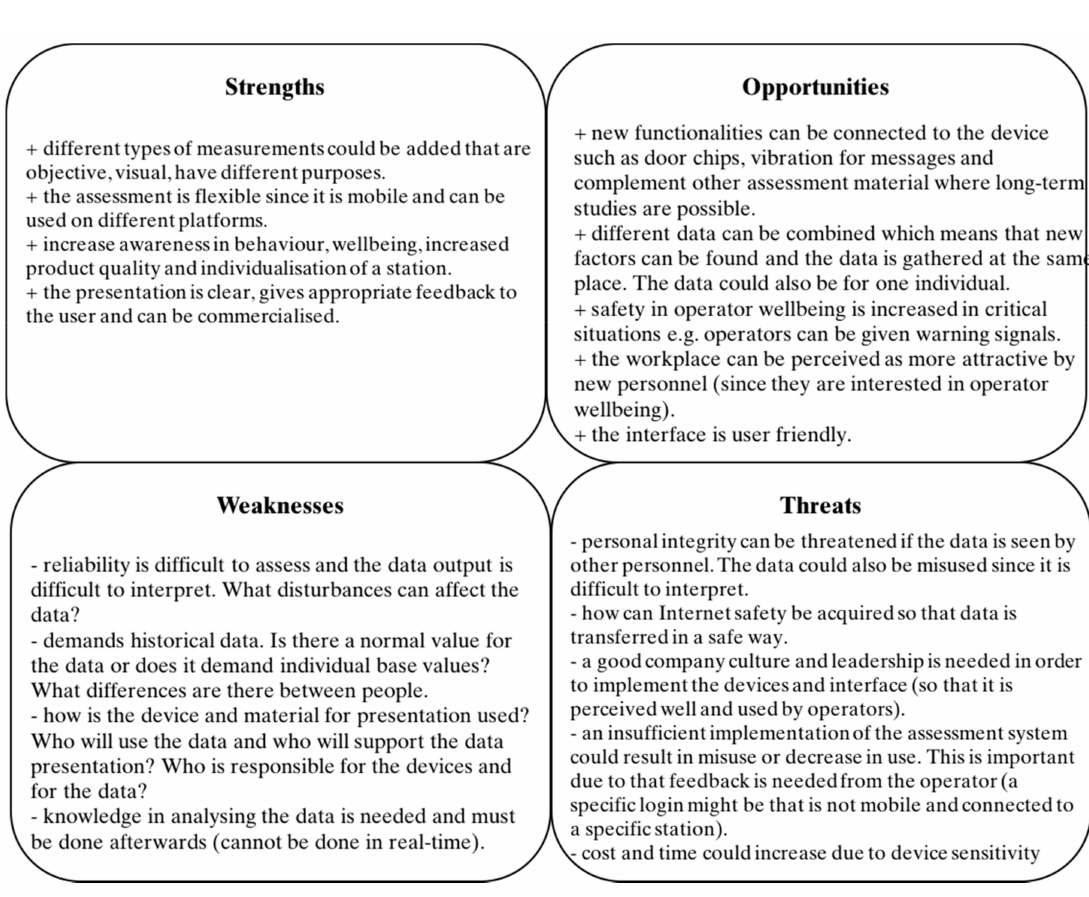
Figure 5. Results from the Strengths, Weaknesses, Opportunities and Threats (SWOT)